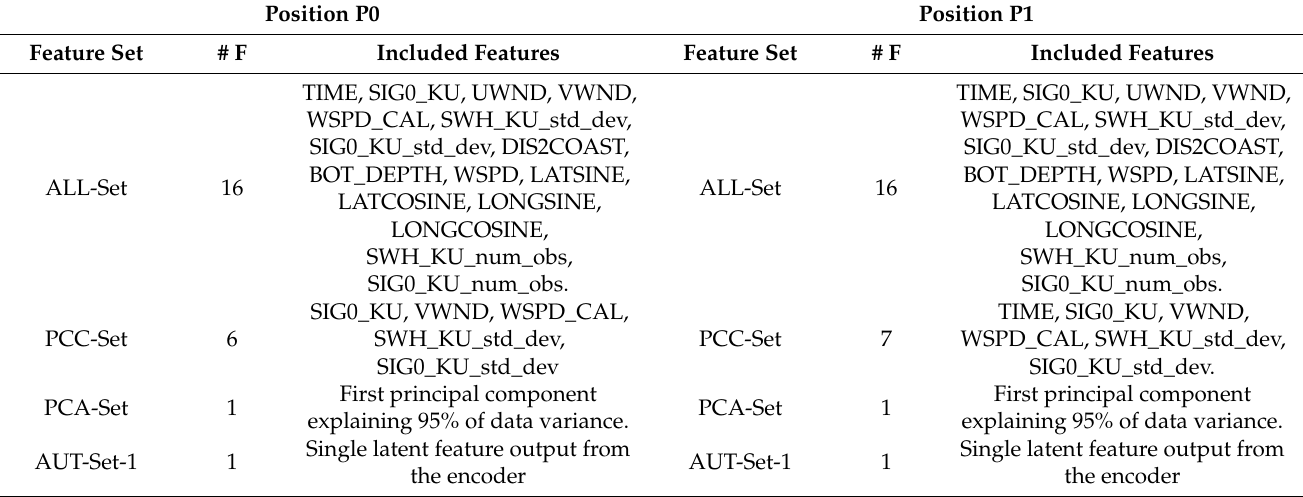
Table 8. Feature sets used for modeling SWH_KU_CAL using Positions P0 and P1 data. # F denotes the number of features included in the feature